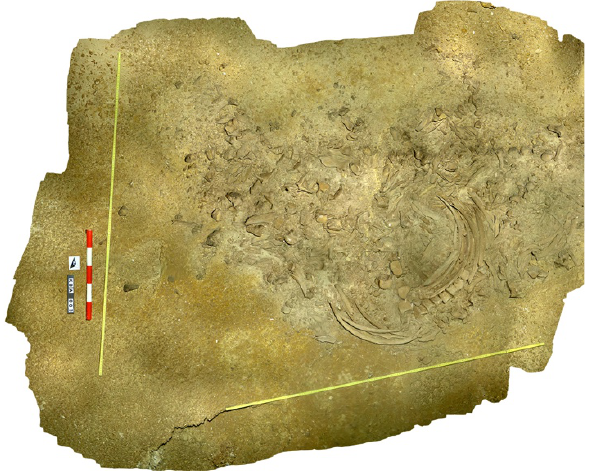
Figure 11 . Example of an acquisition zone, including two yellow folding rulers for scale and delimiting the work area. N.B.: the legend zone can be seen on the left